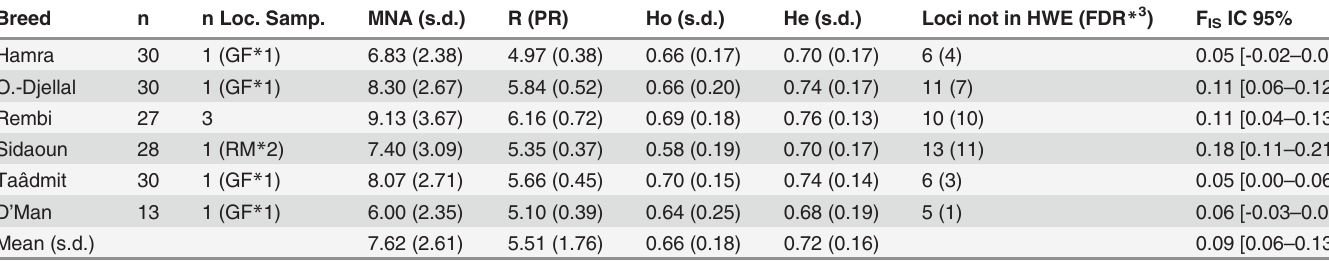
Table 1. Genetic diversity measured by breed.